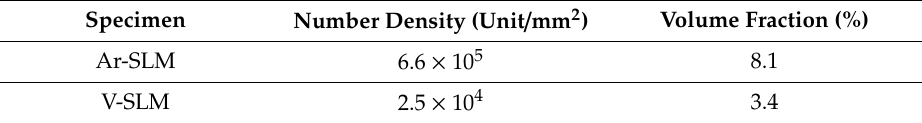
Table 6. Oxygen content of the powder and the SLM-fabricated specimens (ppm).